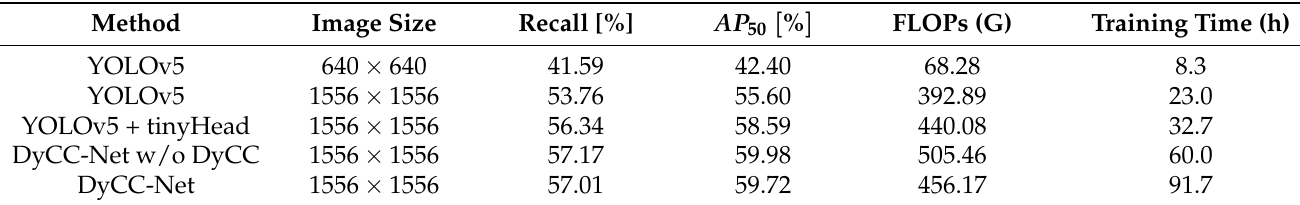
Table 4. The analysis of detection accuracy of the proposed